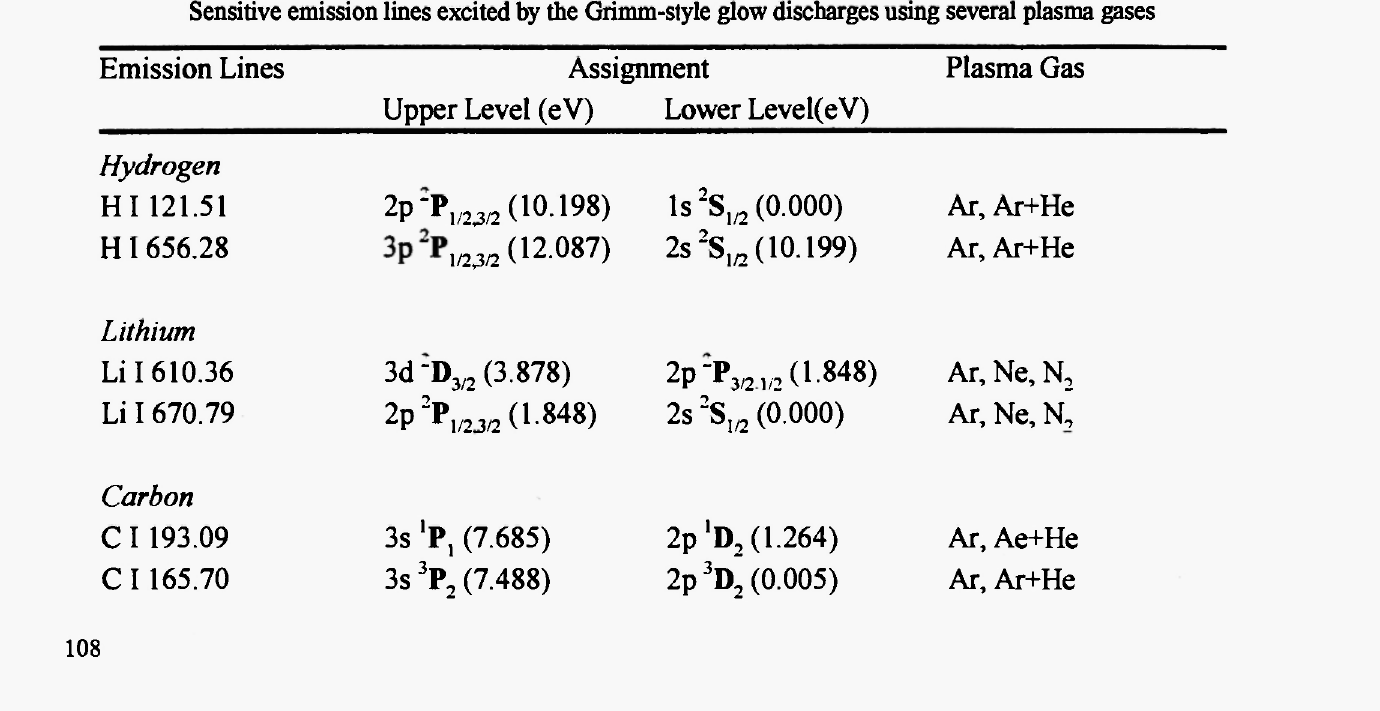
Sensitive emission lines excited by the Grimm-slyle glow discharges using several plasma gases Emission